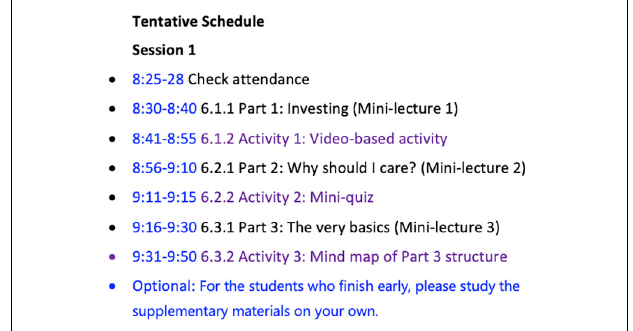
FIGURE 1 | An example of a tentative schedule of an SRL session.